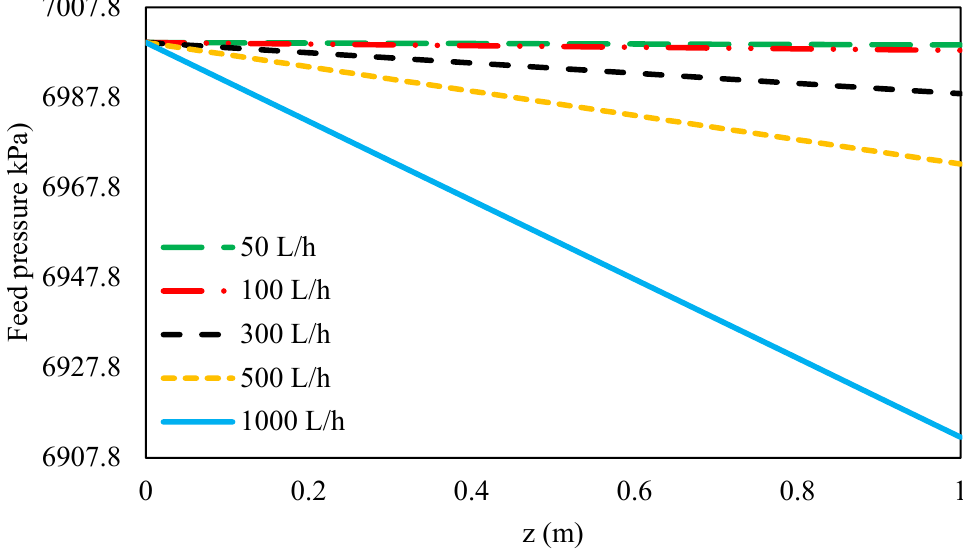
Figure 8. Feed pressure along the feed flow direction at different feed flow rates and 70 bar inlet feed pressure.